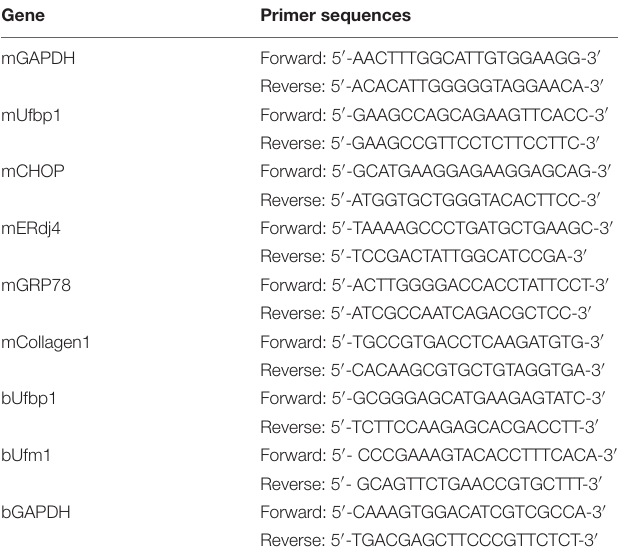
TABLE 1 | Primers used for QRT-PCR (m, mouse; b, bos taurus). Gene Primer